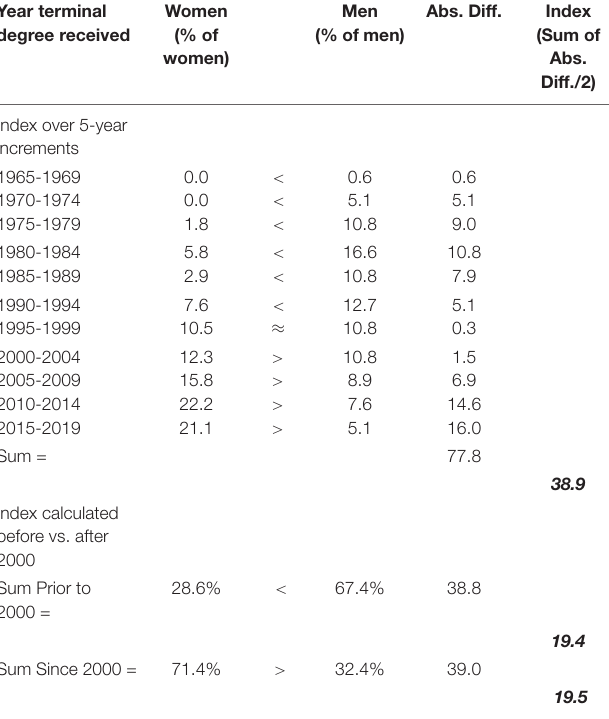
TABLE 3 | Index of gender dissimilarity within forensic psychology over